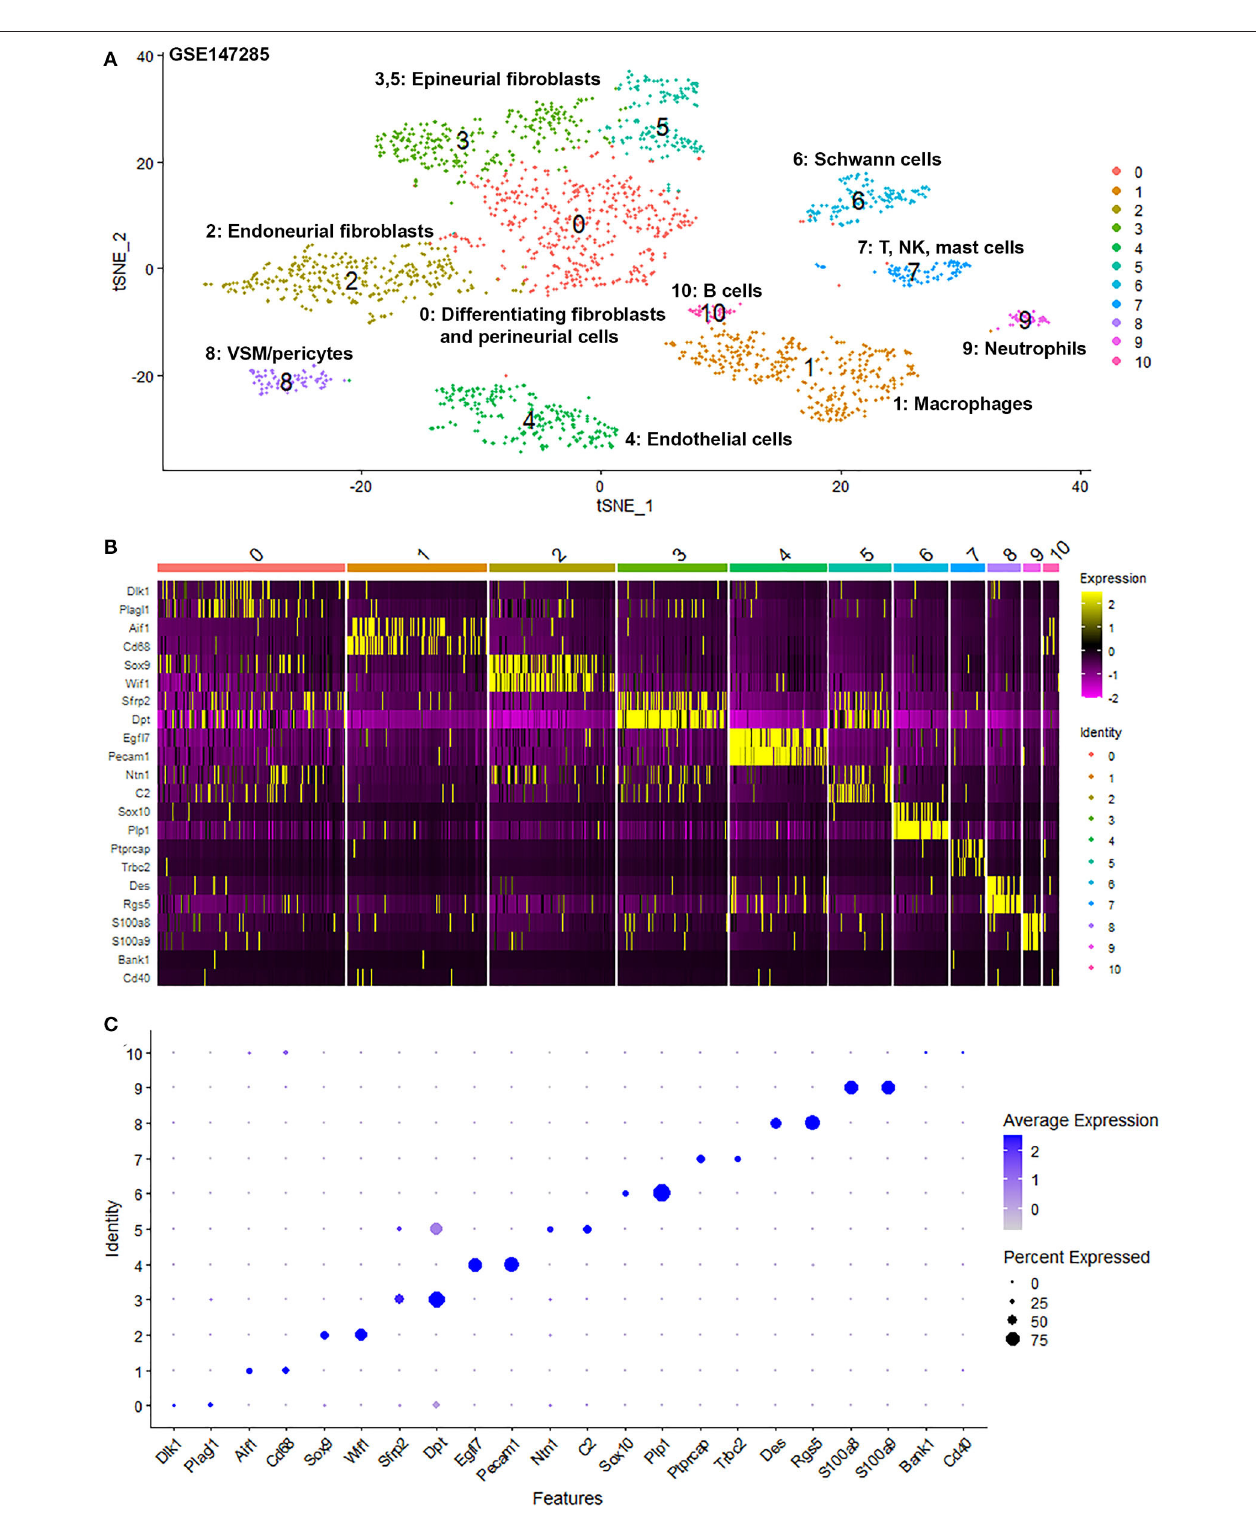
FIGURE 2 | Single cell transcriptomics (GSE147285) defines cellular phenotypes in day 3 post-injury distal mouse sciatic nerve. (A) tSNE visualization of cell clusters in day 3 post-injury distal mouse sciatic nerve. 0: Differentiating fibroblasts and perineurial cells; 1: Macrophages; 2: Endoneurial fibroblasts; 3 and 5: Epineurial fibroblasts; 4: Endothelial cells; 6: Schwann cells; 7: T, NK and mast cells; 8: VSM/pericytes; 9: Neutrophils; 10: B cells. (B) Heat map of selected marker genes for each cell cluster. (C) Dot plot of selected marker genes for each cell cluster.